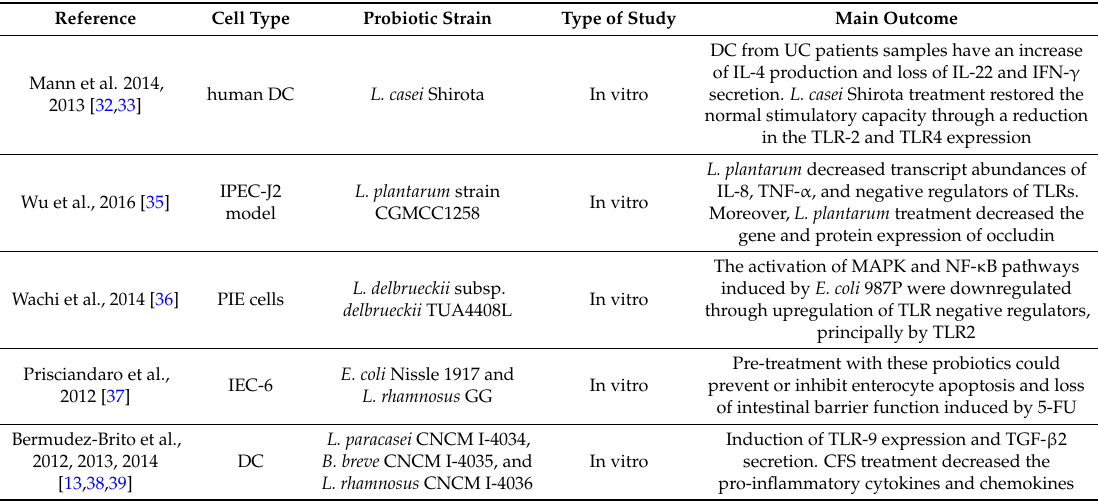
Table 1. Summary of probiotic anti-inflammatory effects in In Vitro